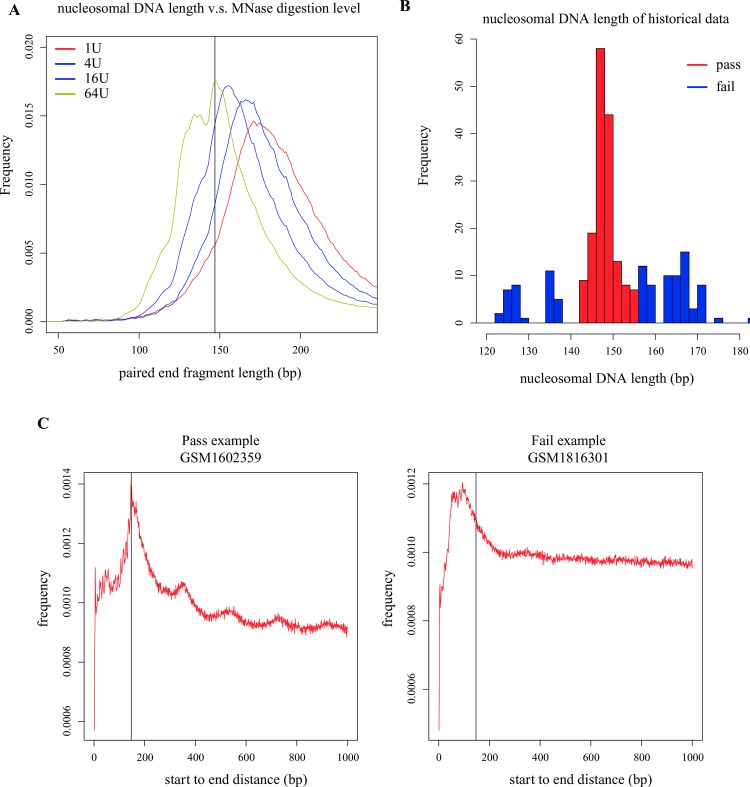
Nucleosomal DNA length distribution.(A) The MNase digestion level (concentration) is related to the nucleosomal DNA length: samples with a higher MNase concentration exhibite shorter nucleosomal DNA length, whereas lower concentration samples exhibite longer nucleosomal DNA length. The MNase-seq data used for the comparison were obtained from a previous study in mouse ESCs (GSM2083105, GSM2083106, GSM1083107, GSM1083108). (B) The distribution of the nucleosome length from all of the historical data. Nucleosome length < 140 or > 155 was determined as “Fail” (blue) in this measurement. (C) Examples of MNase-seq data with “Pass” and “Fail” in this measurement. The vertical line labels 147 bp.